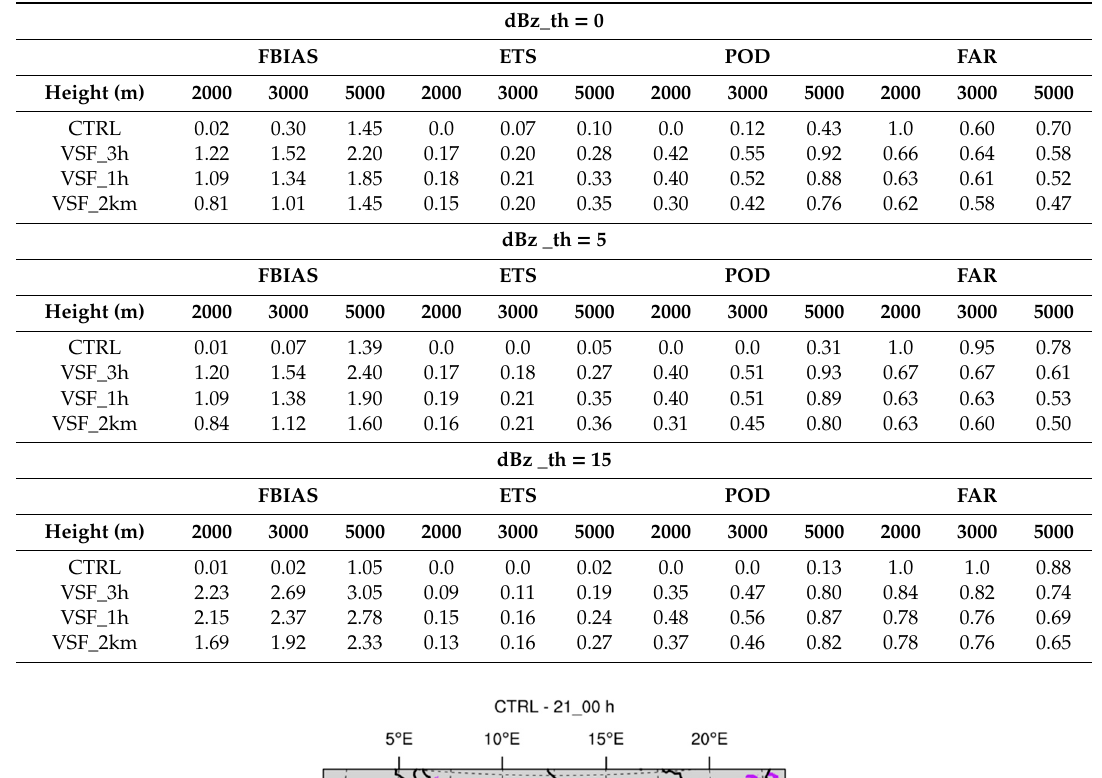
Table 3. Scores of simulated reflectivity for three di ff erent reflectivity thresholds (0, 5, and 15 dBz) and for three observation levels (2000, 3000, and 5000 m). Scores are computed for the four VSF configurations considered in the paper (CTRL, VSF_3h, VFS_1 h, VSF_2km). FBIAS is the